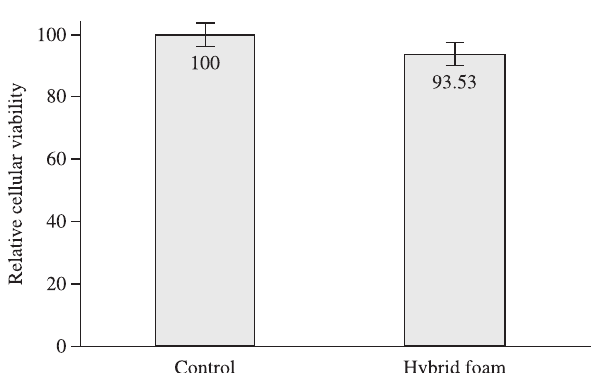
Figure 9. Osteoblast viability evaluated by MTT assay 4 days later, at 5 x 10 4 cells/mL density in the presence of hybrid of the bioactive glass 50 wt. (%) PVA foam.